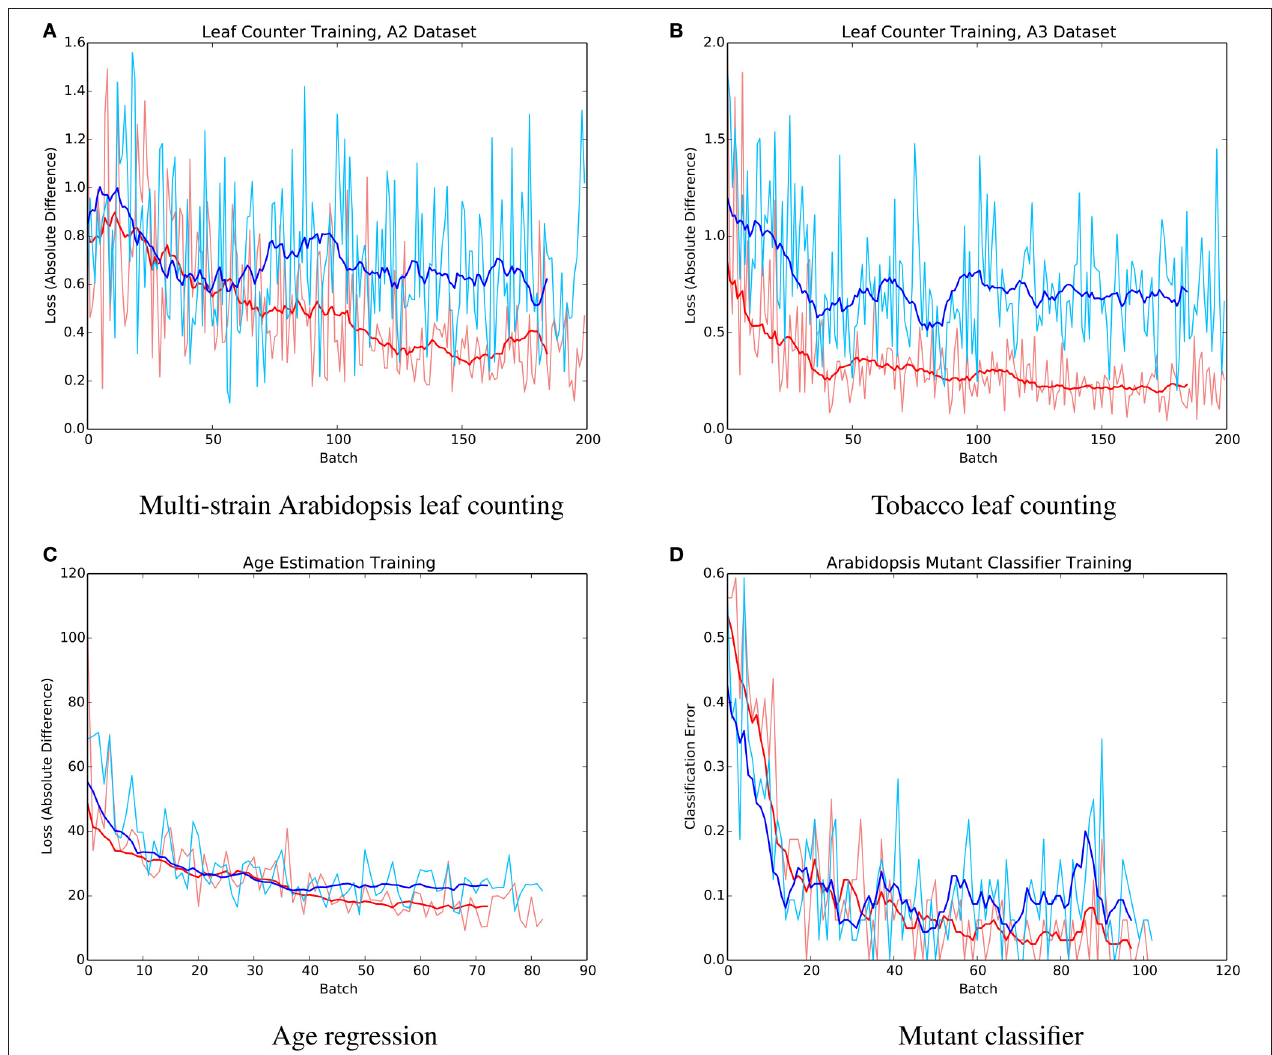
FIGURE 5 | Example training (red) and testing (blue) curves for several benchmark tasks. (A) Multi-strain Arabidopsis leaf counting. (B) Tobacco leaf counting. (C) Age regression. (D) Mutant